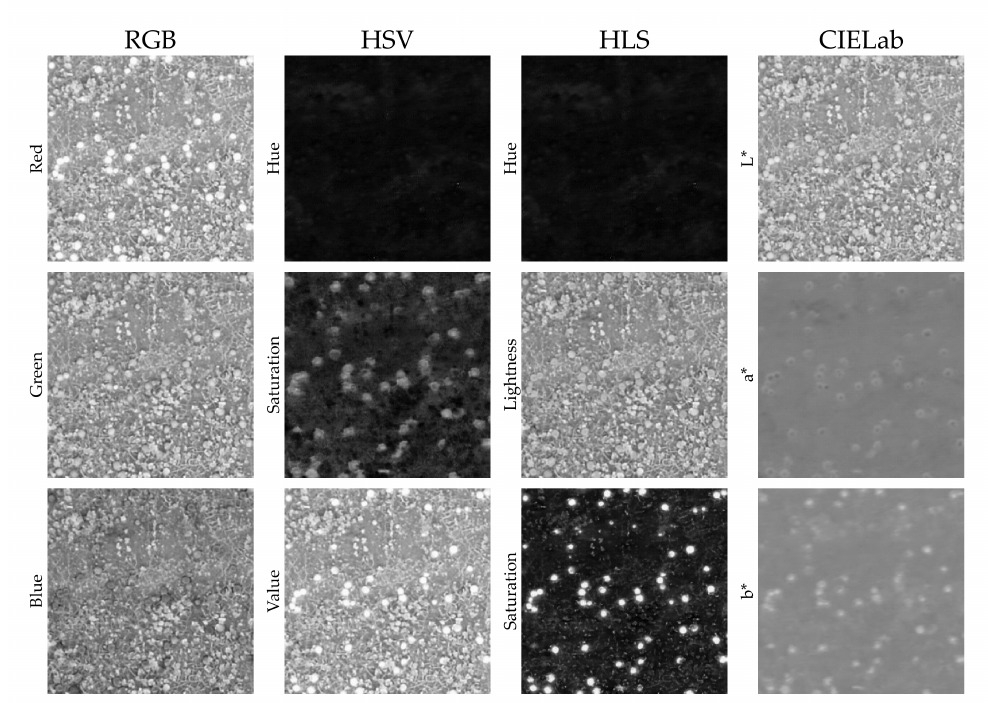
Figure 2. Randomly selected tile with pumpkins presented in four different color spaces separated by